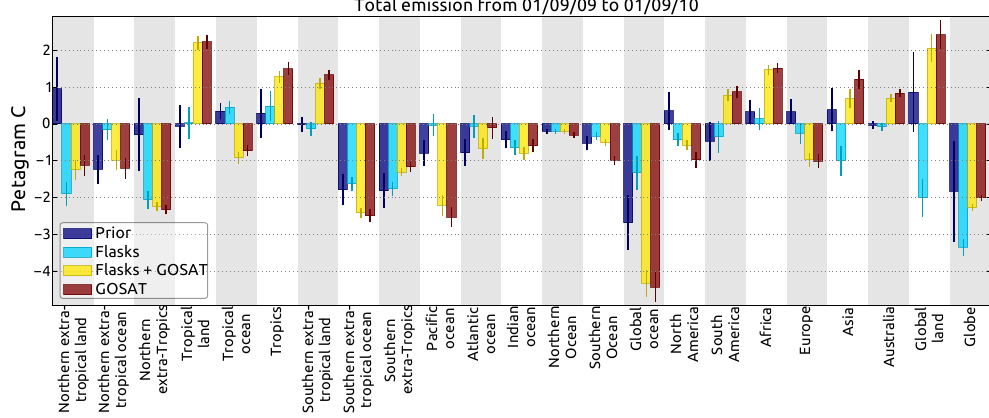
Fig. 8. Aggregated emission between 1 September 2009 and 1 September 2010, partitioned over larger regions such as different continents and latitude bands. The emission figures do not include fossil fuel emissions. Error bars denote 1 σ errors.